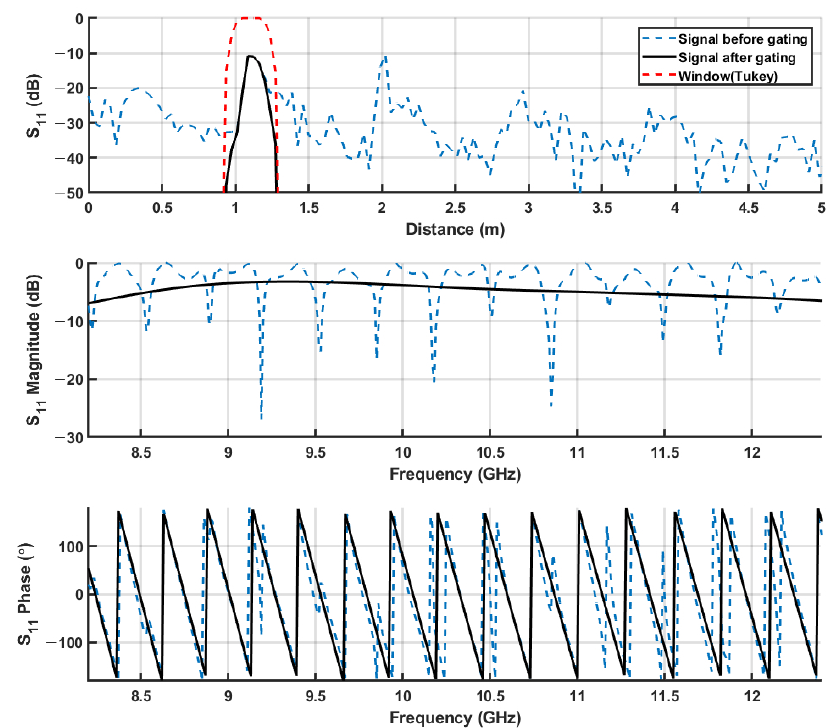
Figure 2. The process of